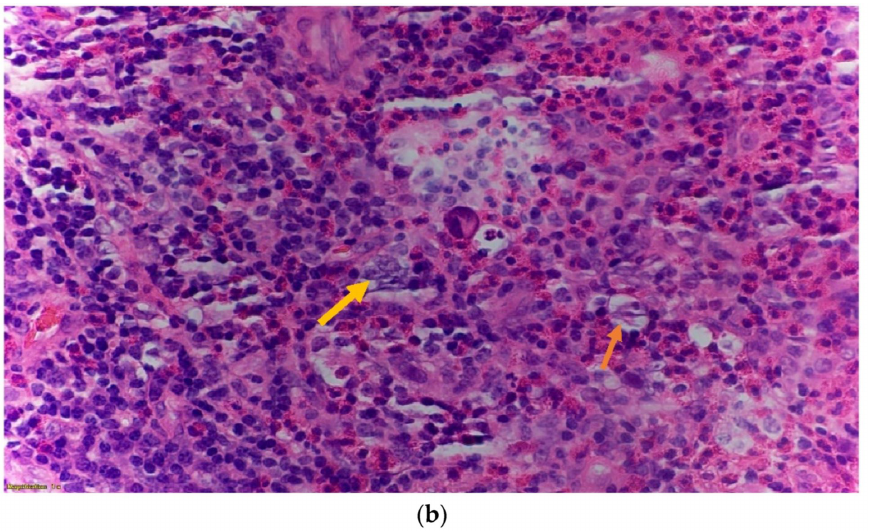
Figure 4. ( a ): lymph node microscopic slide magnified (40 × ) showing scattered lacunar cells (orange arrow) and abundant eosinophils in classical Hodgkin lymphoma. ( b ): H & E stain of a peripheral lymph node microscopic slide magnified (60 × ) showing numerous abnormal cells with bilobated nuclei, vesicular chromatin, prominent nucleoli, and abundant cytoplasm, indicative of mononuclear variants of Reed-Sternberg cell (yellow arrow).